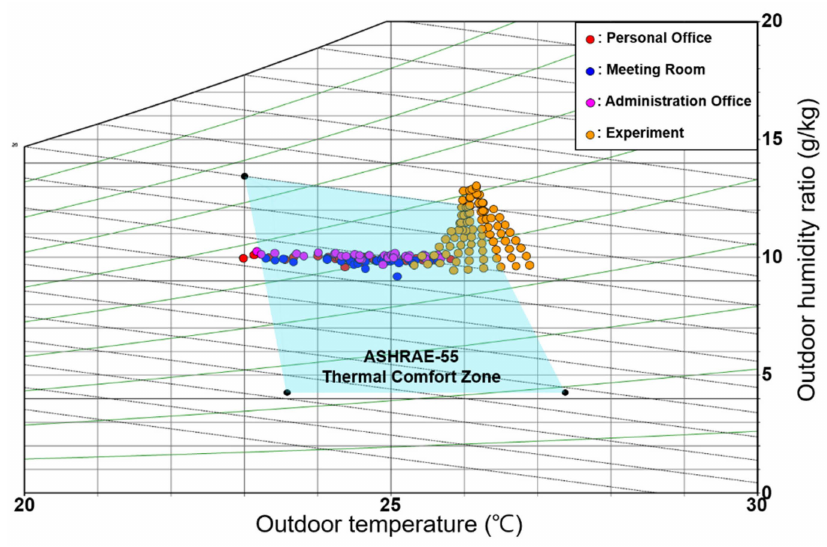
Figure 8. Changes in thermal comfort conditions of cooling spaces with an increase in the desiccant rotor capacity.